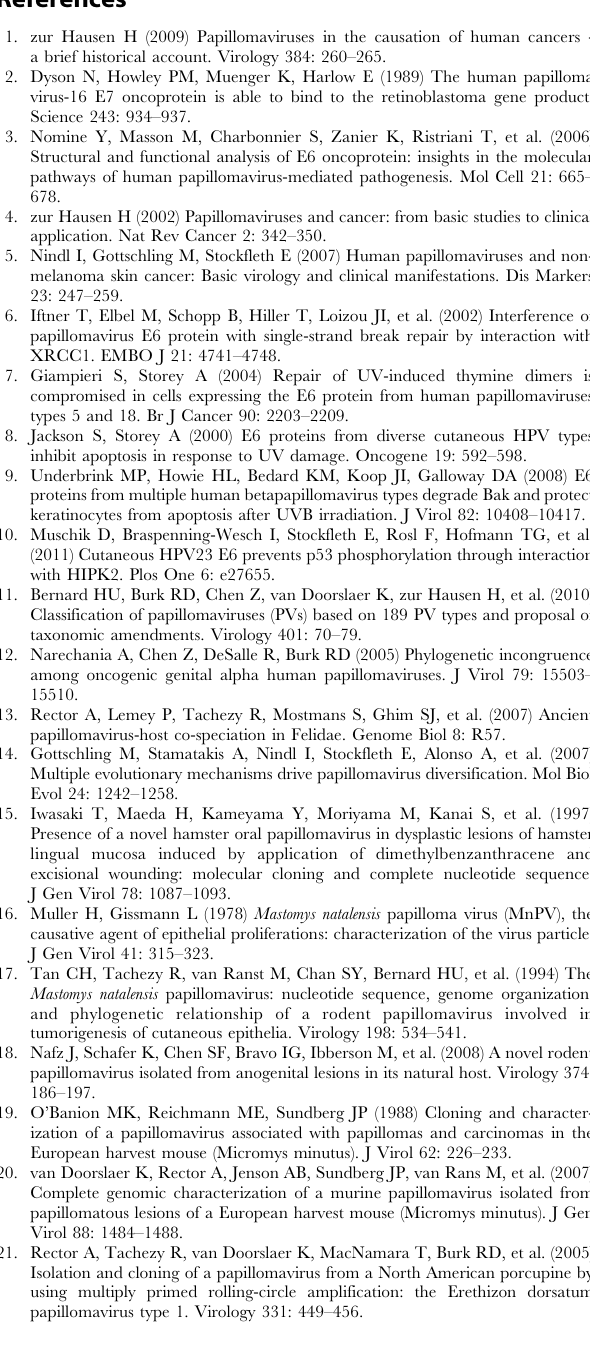
Table S3 Predicted transcription factor binding sites and other regulatory elements in the rodent PV gen-